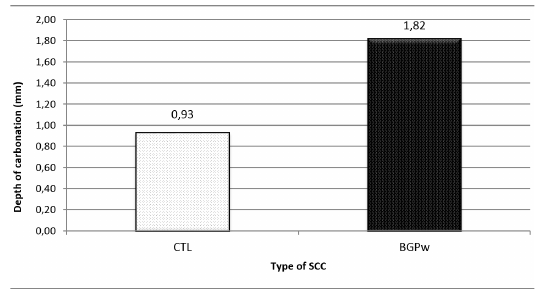
Figure 11. Carbonation depth results.